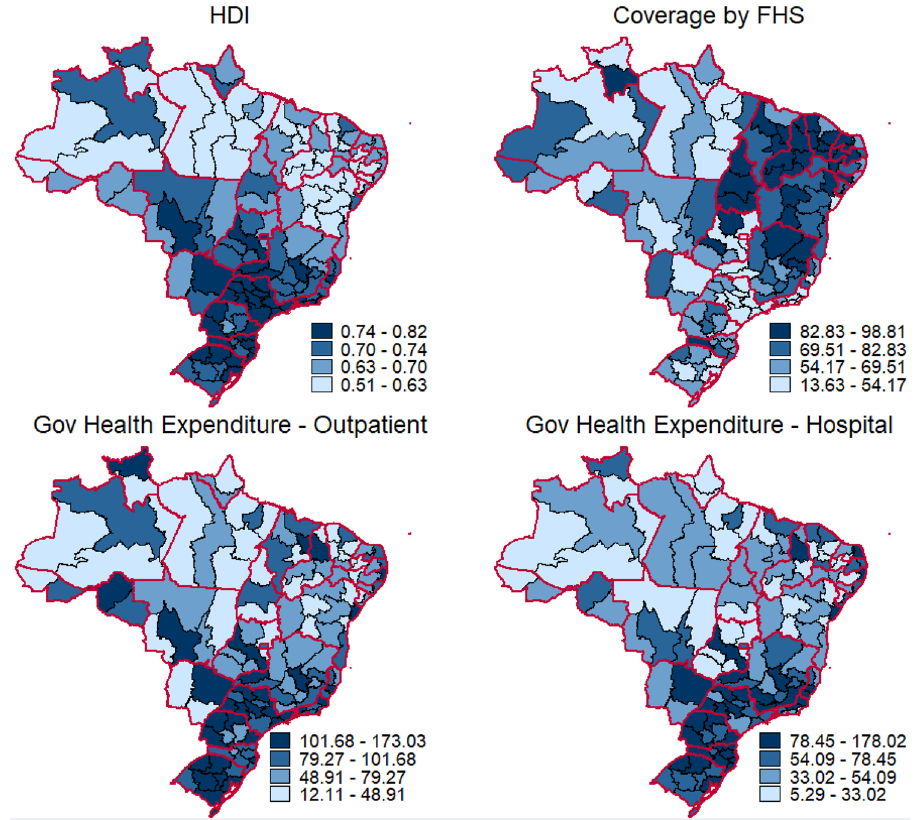
Figure 2. Distribution of covariates in Brazil’s intermediate geographic regions: the Human Development Index (HDI) in 2010; coverage of the Family Health Strategy (FHS) in 2018; and per capita government expenditure in outpatient health care, and hospitalizations, in Brazilians Reals, in 2018. This figure was created by the authors, using Stata 14.0 software and the shapefiles provided by the Brazilian Institute of Geography and Statistics